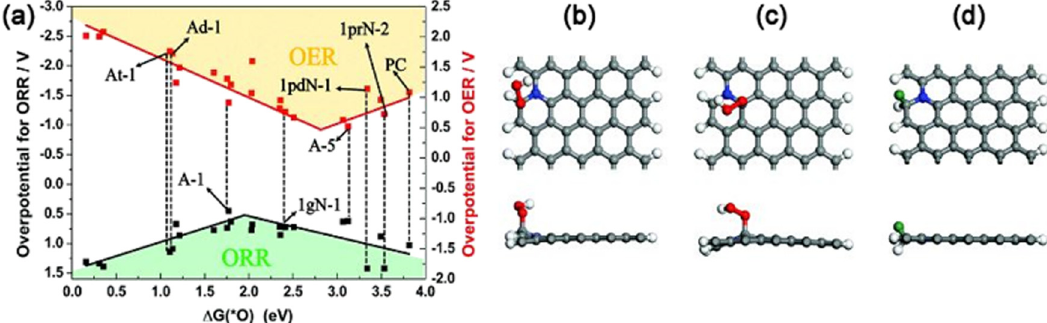
Figure 11: ( a ) Volcano plots for the ORR and OER are prepared by sketching the overpotential as the action of Δ G ( *O ) at di ff erent available active sites. Top and side perspectives of active site ( b ) A - 1 is shown for the ORR, ( c ) A - 3 is shown for the OER, and ( d ) A - 1 is shown for the HER, the green ball performing the adsorbed H ( θ = 2.27% ) . Reprinted from [ 166 ] , copyright 2019, Royal Society of